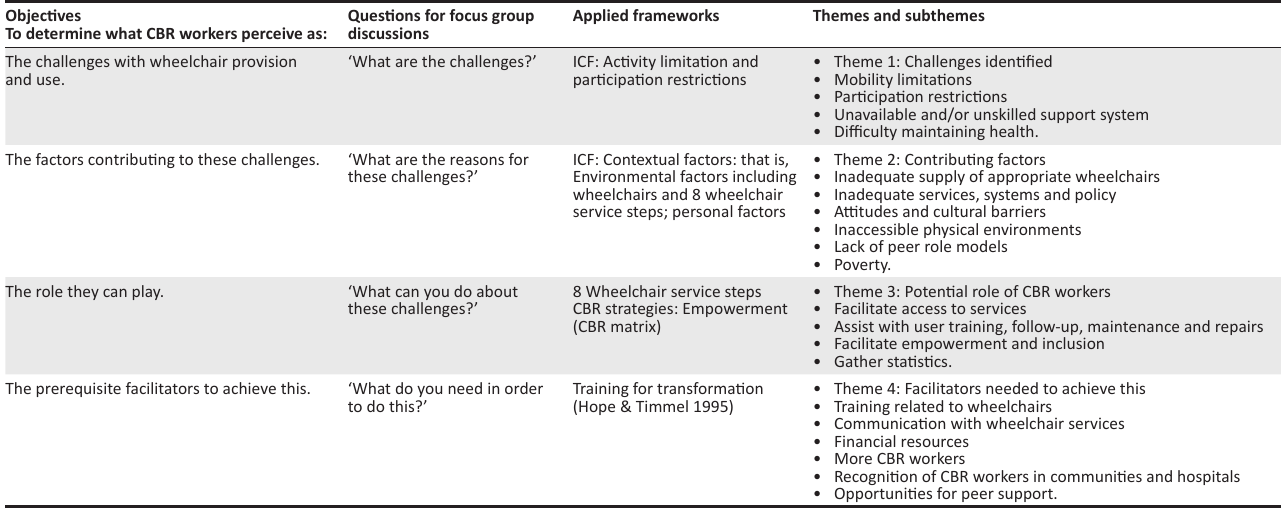
TABLE 5: Tabulated overview of the link between the objectives, the guiding questions, frameworks applied (for analysis), themes and subthemes. Objectives Questions for focus group To determine what CBR workers perceive as: